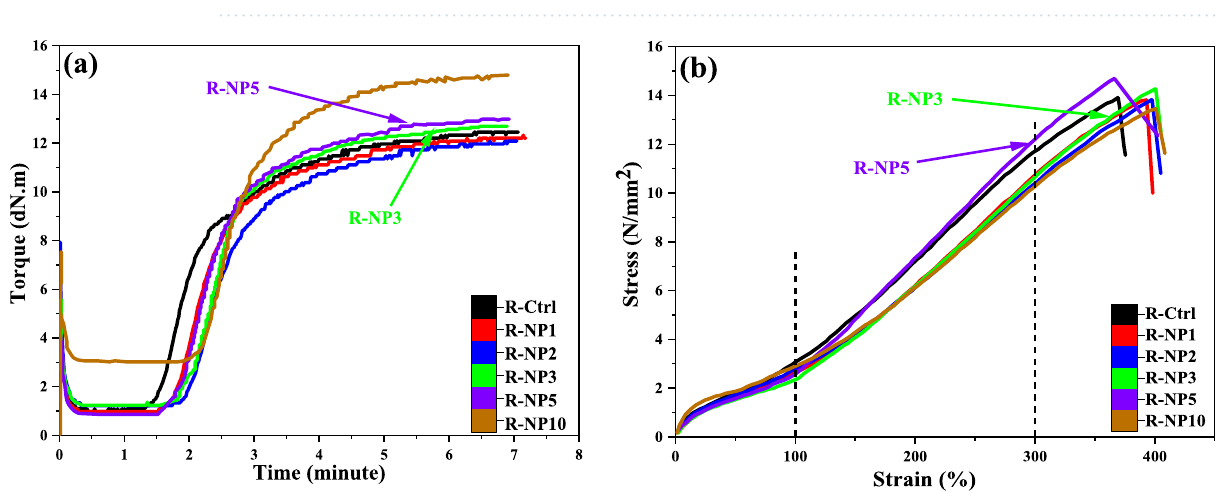
Figure 4. The curing and mechanical behaviors of the R-NP samples; ( a ) MDR results and ( b ) tensile test